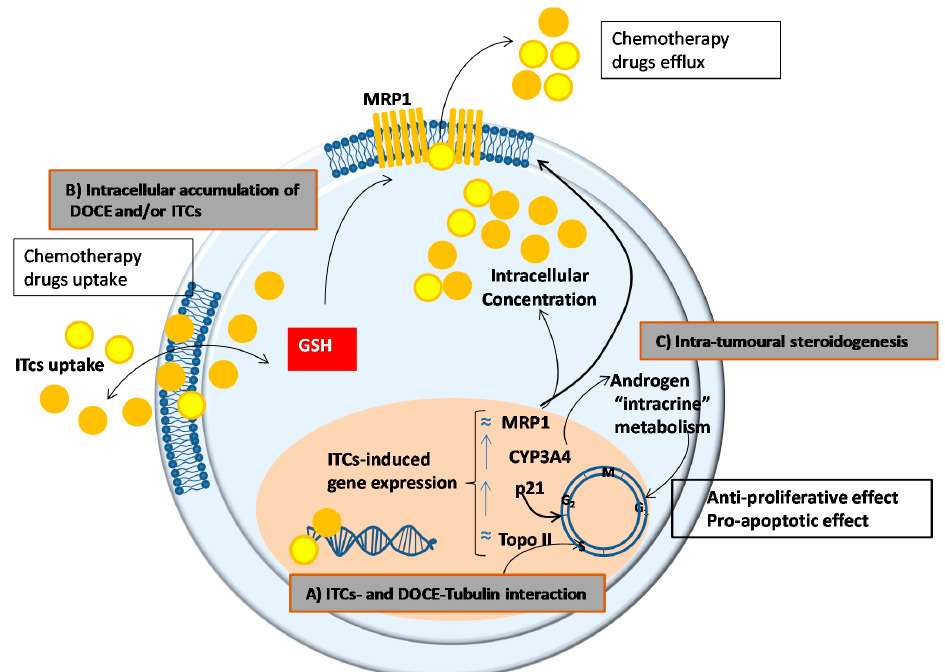
Figure 7. Potential mechanisms to explain the synergistic effect of combined isothiocyanate (ITC, orange circles) and docetaxel (DOCE, yellow circles) in prostate cancer cells. ( A ) Interaction of